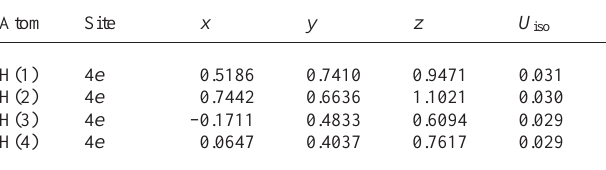
Table 2. Atomic coordinates and displacement parameters (in Å 2 ) .